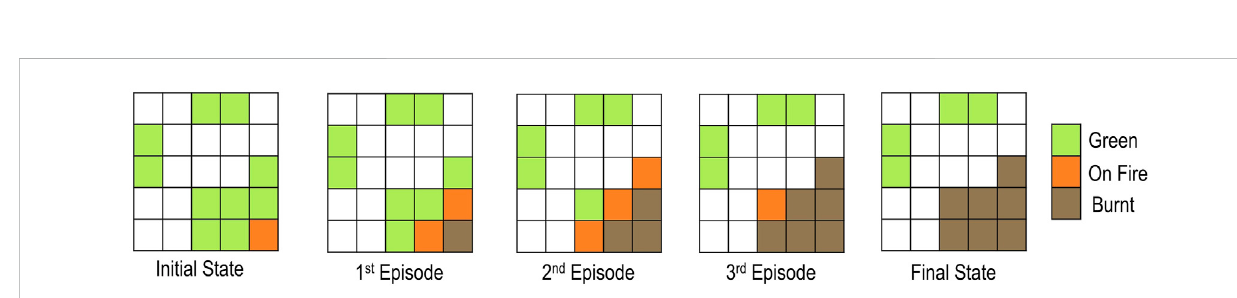
FIGURE 8 “ Fire propagation ” algorithm illustration per episode. The function ’ s output is the burnt cells.